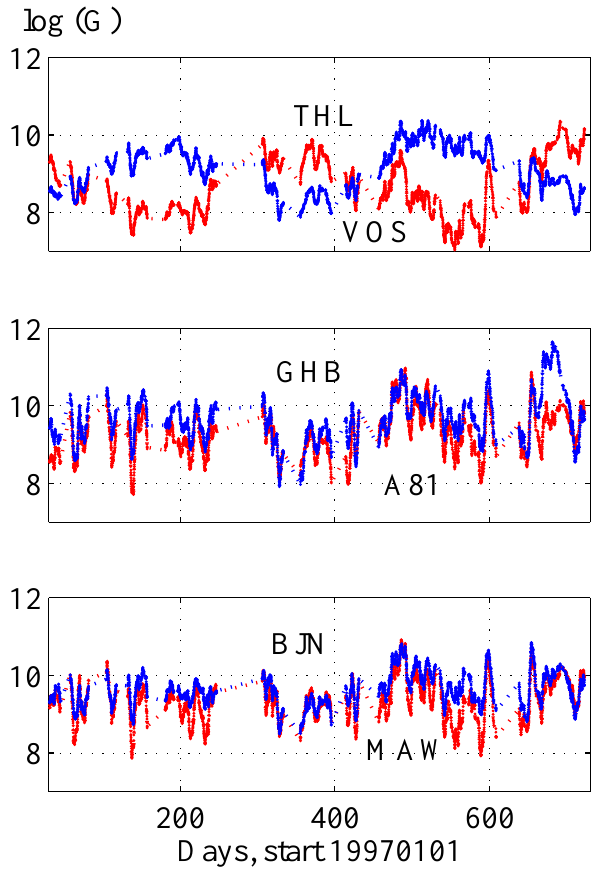
Fig. 1. The total horizontal spectral power density (in log scale) for the period 1997–1998 at 3 nearly conjugated stations VOS-THL (polar cap), A81-GHB and MAW-BJN (auroral) from the Southern (red) and Northern Hemispheres (blue). X-scale is day numbers starting from 1 January 1997. Codes for Northern (Southern) sta- tions are given in upper (lower) part of each